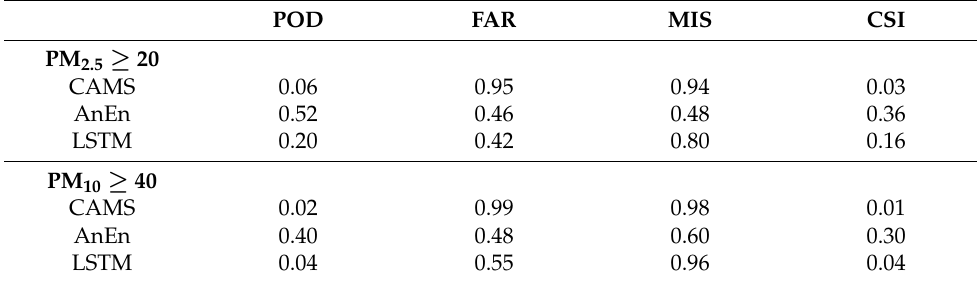
Table 5. The probability of detection (POD), false alarm rate (FAR), critical success index (CIS) and miss rate (MIS) from CAMS, AnEn and LSTM for PM 2.5 and PM 10 . POD FAR MIS CSI PM 2.5 ≥